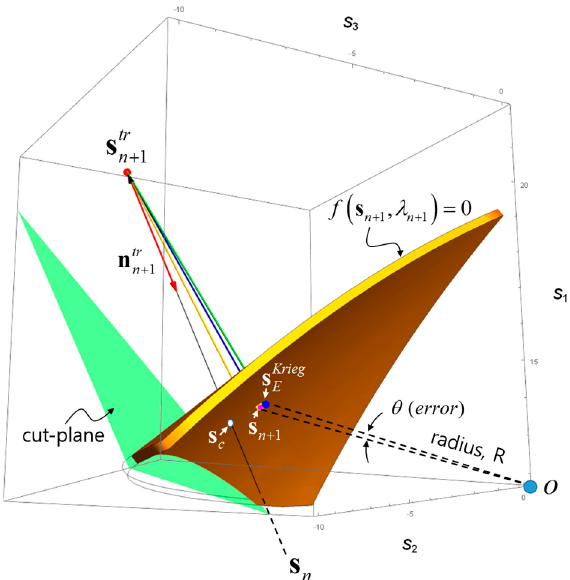
Figure 4. Radial return algorithm: trial stress over the yield surface and corrected final stress onto the yield surface: calculation and visualization using Mathematica. Metals 2018 , 8 , 66